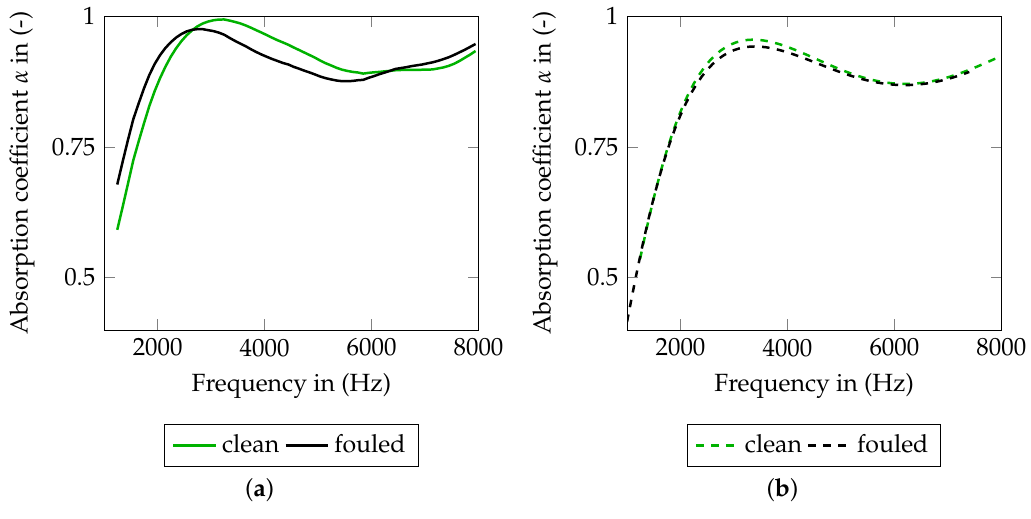
Figure 9. Comparison of clean and fouled SFF 100 for a staple size of 0.02m. ( a ) experimental data; and ( b ) numerical